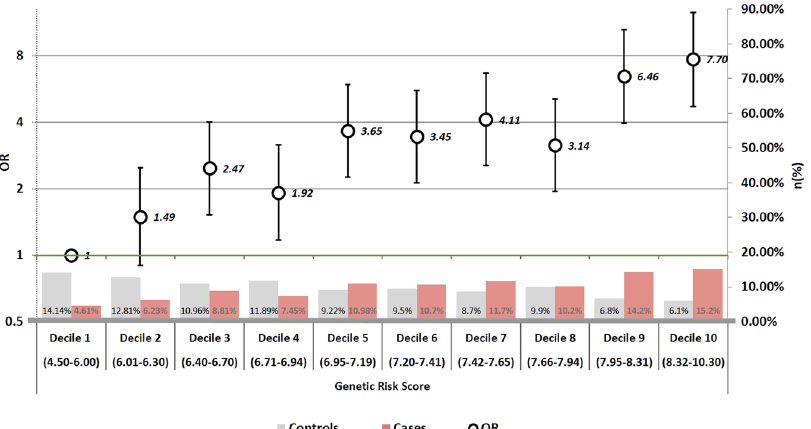
Figure 1. Distribution of prostate cancer cases and controls, and odds ratios for each decile of the genetic risk score. The left axis scale indicates the OR for prostate cancer according to deciles of points in the genetic score. The decile 1 (4.5–6.0 points) has been selected as reference category (OR = 1). The right axis scale indicates the proportion of cases and controls shown in bars for each decile. Parentheses include the points in the score.